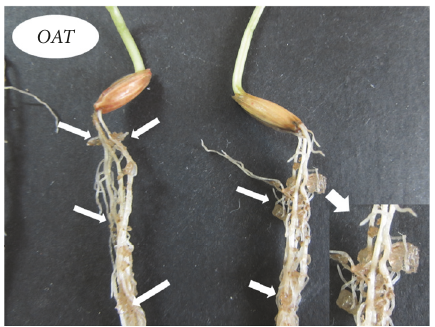
Figure 2: Digital photograph of the oat root zone in the presence of Tulipalin A-based hydrogels.